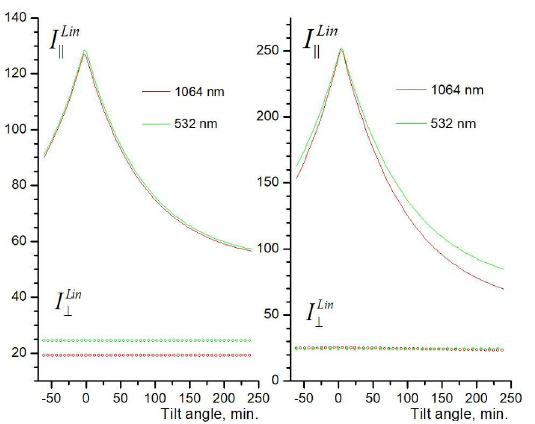
Fig. 5. Angle dependencies of polarization components for 532 nm (green) and 1064 nm